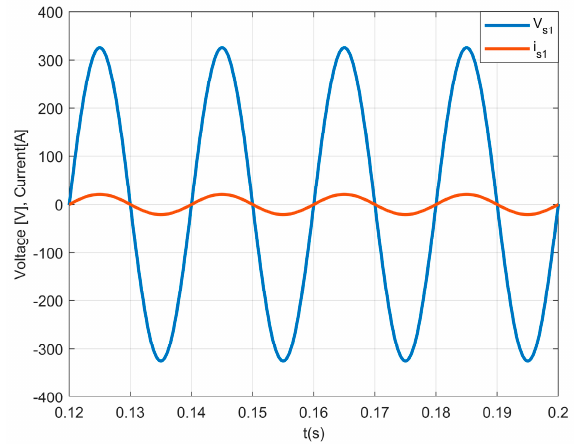
Figure 12. The grid voltage and current in phase 1 with the rectifier operating in Buck mode.